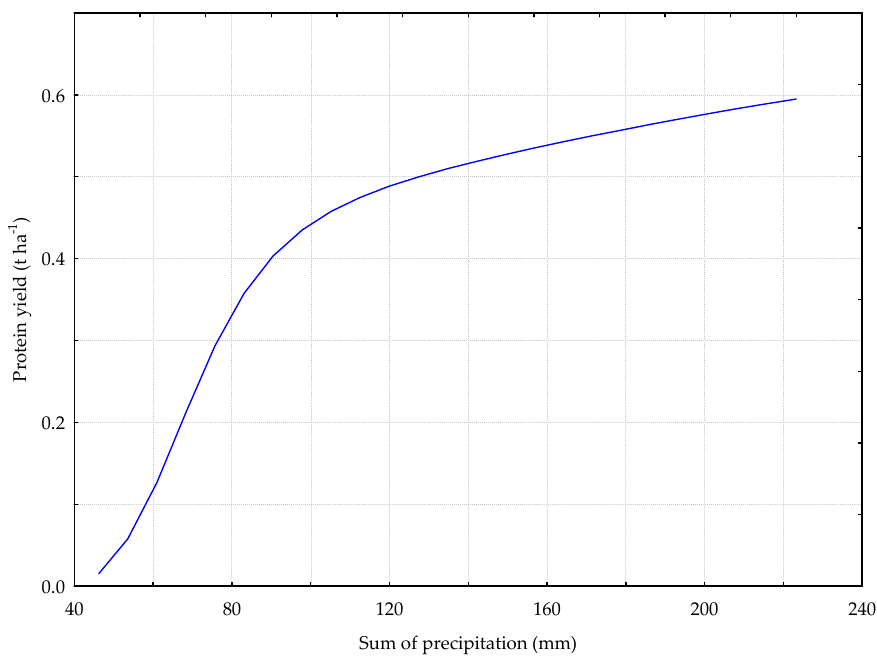
Figure 8. The DIG_GB model. The response chart for variables T_AV (rank 1) and %_DMD. Figure 9 shows the relation between the yield of protein from the sward with the predominance of grasses and bird’s foot trefoil and the total rainfall in the test period (PREC_S). As seen from the data, the higher the rainfall in the period ranging from the spring onset of vegetation to the harvest date was, the higher the yield of protein from the harvested biomass was.